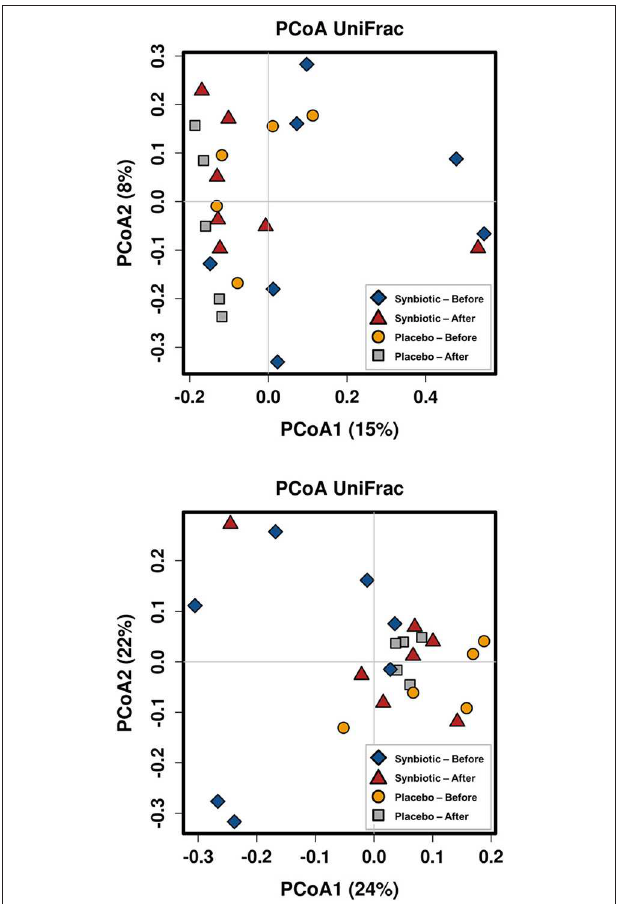
FIGURE 2 | Principal coordinate analysis of the fecal microbiota from healthy dogs switched to hydrolyzed protein diet. Colors are marking individual dogs. Arrows indicate change from day 0 (before diet change) to 6 weeks after diet